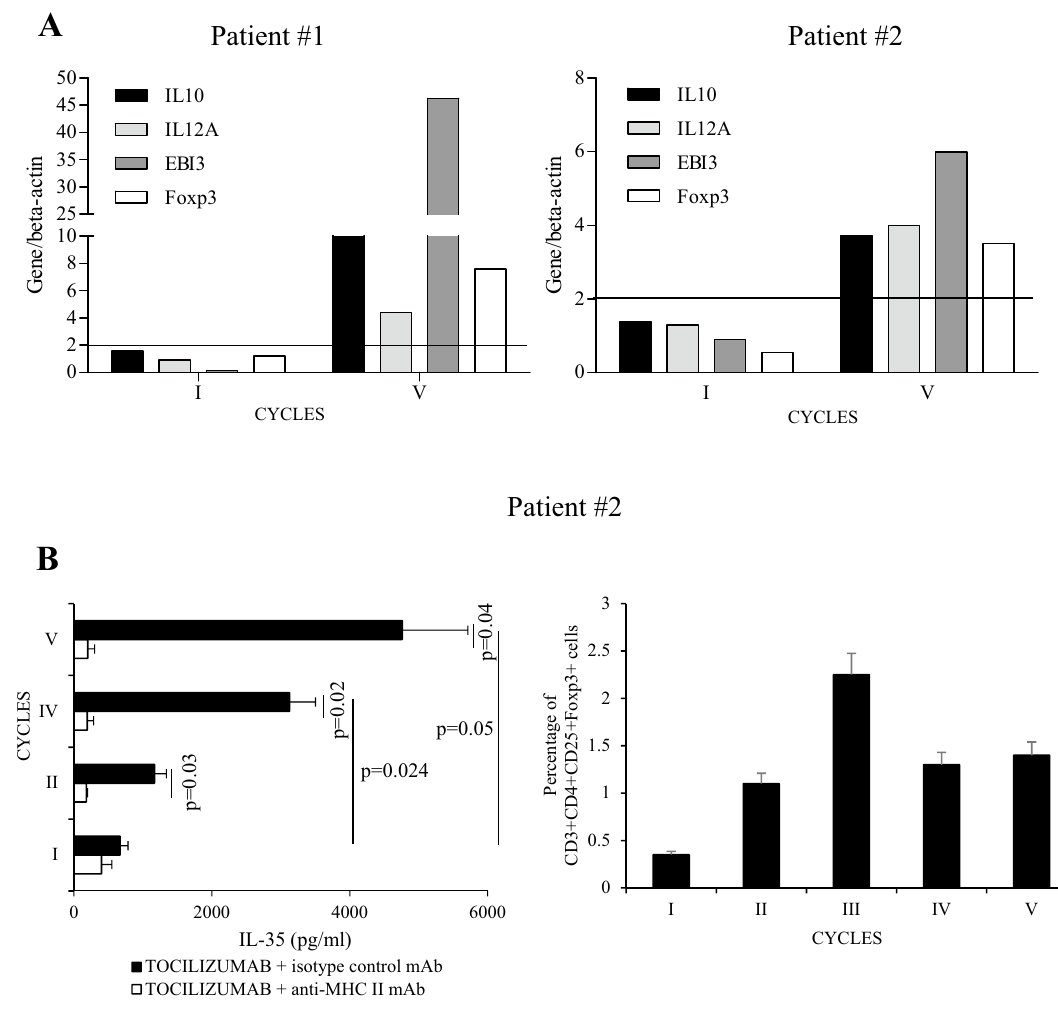
Figure 4. ( A ) mRNA expression of regulatory molecules in drug-stimulated PBMC. ( B ) IL-35 production by tocilizumab-specific PBMC, restricted to MHC class II elements (left panel); FACS analysis of CD25 + Foxp3 + (CD3 + CD4 + gated) cells during the desensitization procedure (right panel). FACS fluorescence-activated cell sorting, IL interleukin, MHC major histocompatibility complex, PBMC peripheral blood mononuclear cells. FACS analysis was performed by “BD FACSCanto II” fluorocytometer and BD FACSDiva software v 6.1.3 (https:// www. bdbio scien ces. com/ en- us/ instr uments/ resea rch- instr uments/ resea rch- softw are/ flow- cytom etry- acqui sition/ facsd iva- softw